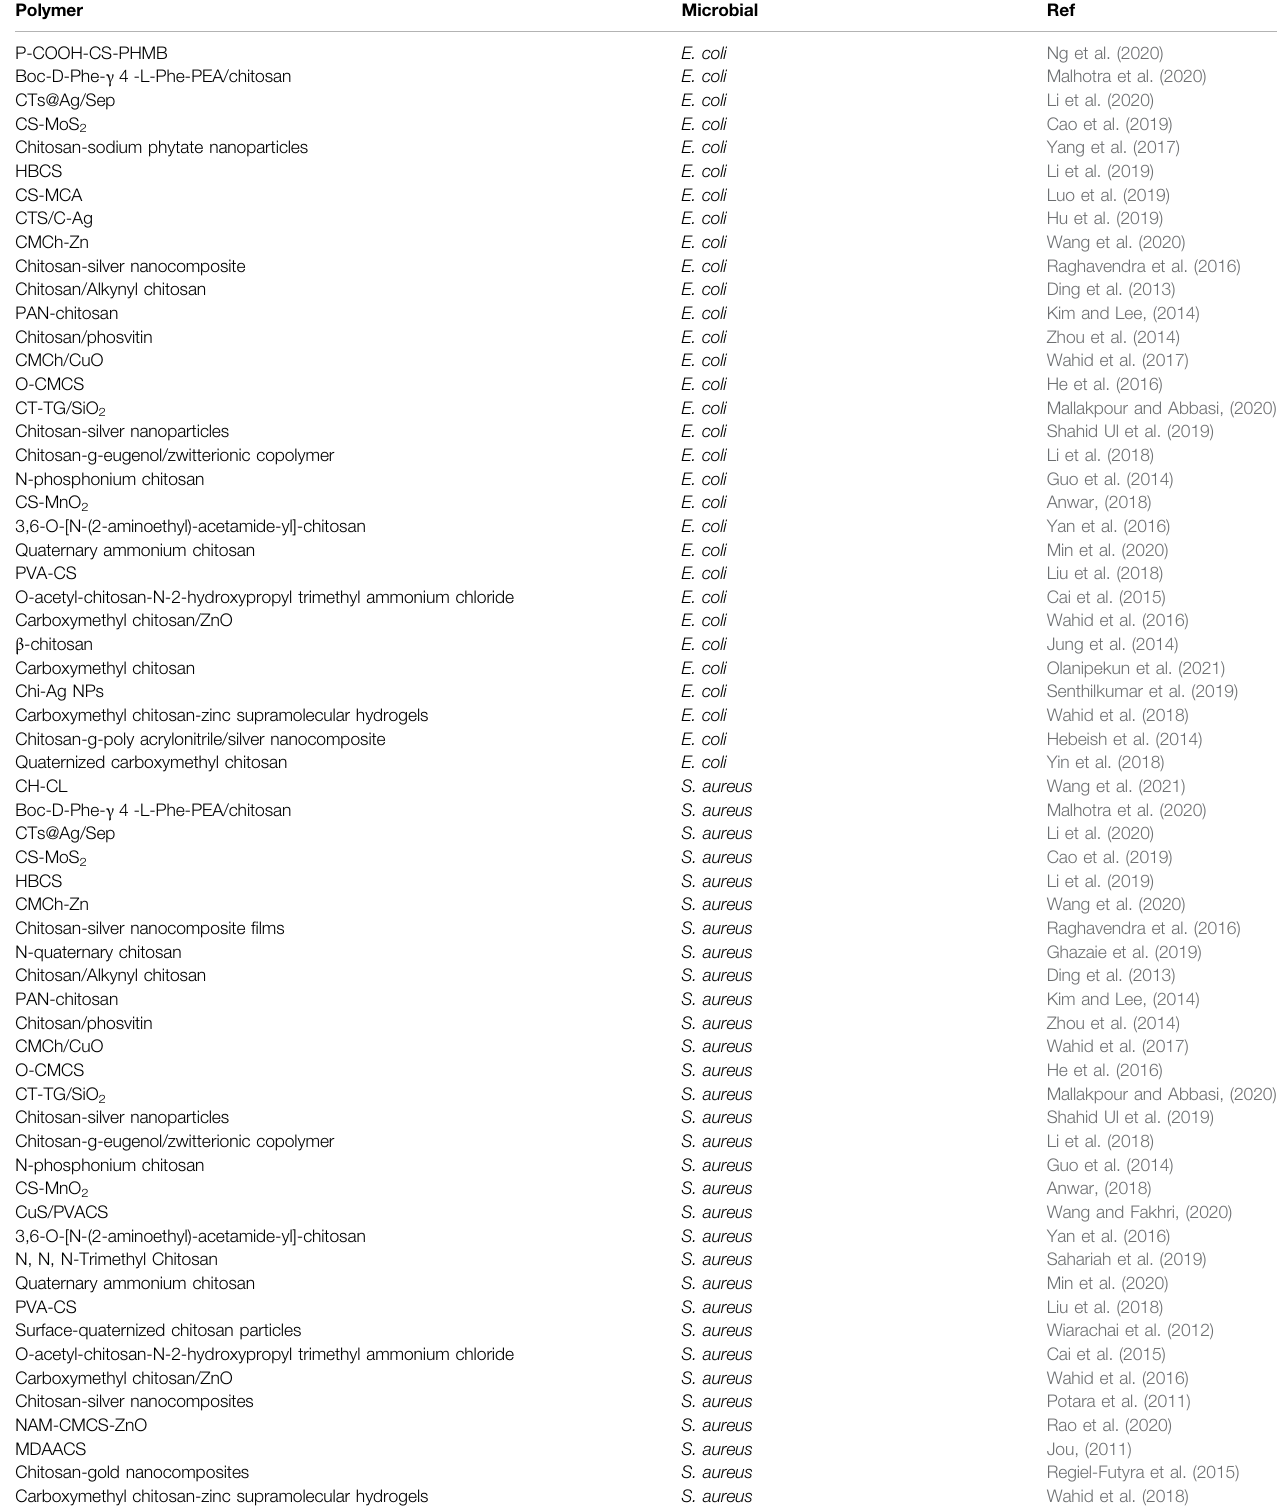
TABLE 1 | Antibacterial effect of chitosan and its derivatives on different microorganisms.